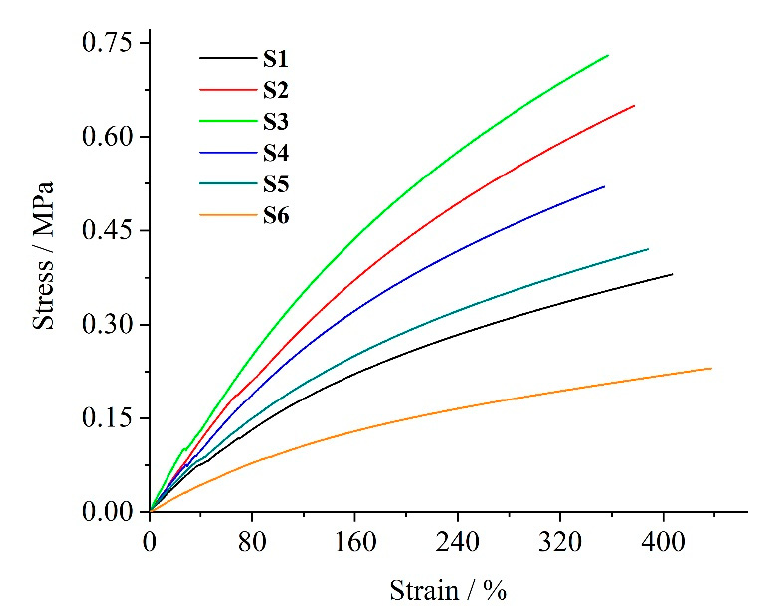
Figure 6. Stress–strain curves of elastomers.